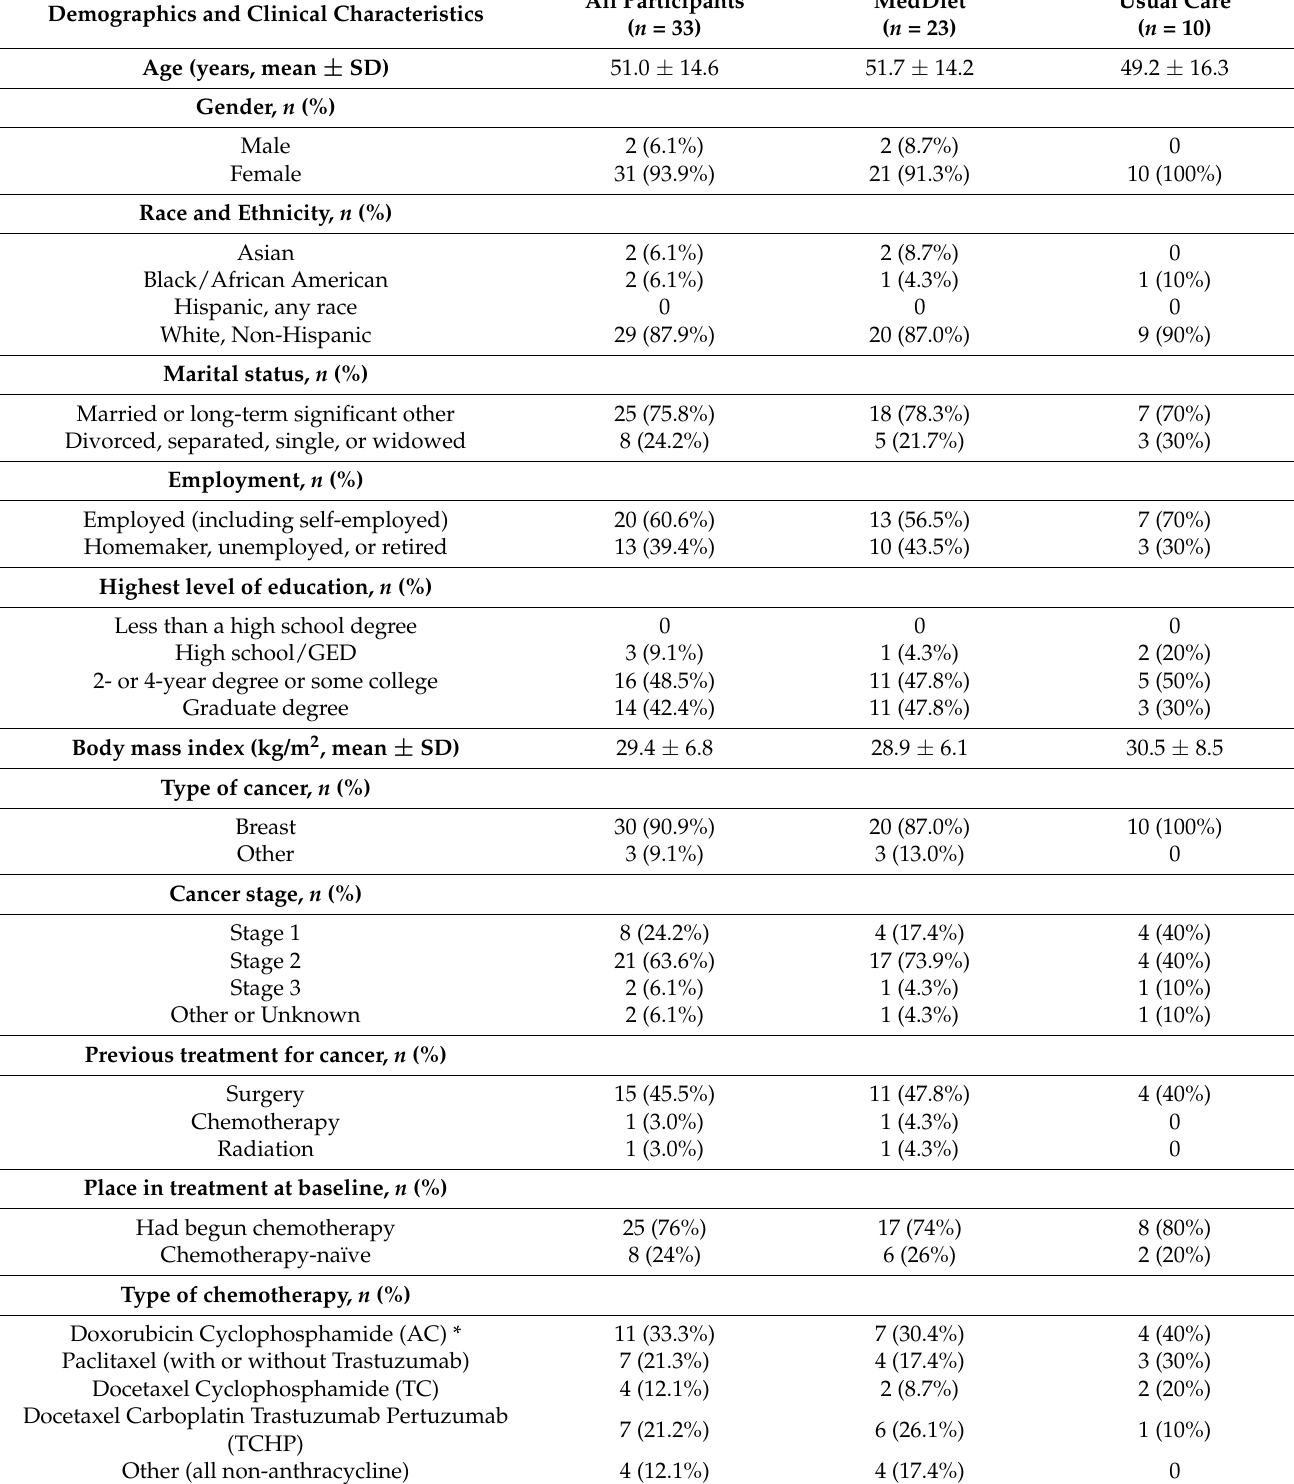
Table 1. Demographics and clinical